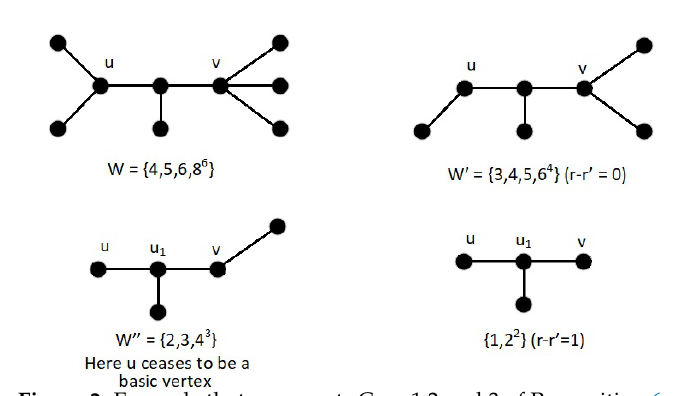
Figure 2. Example that represents Case 1,2 and 3 of Proposition